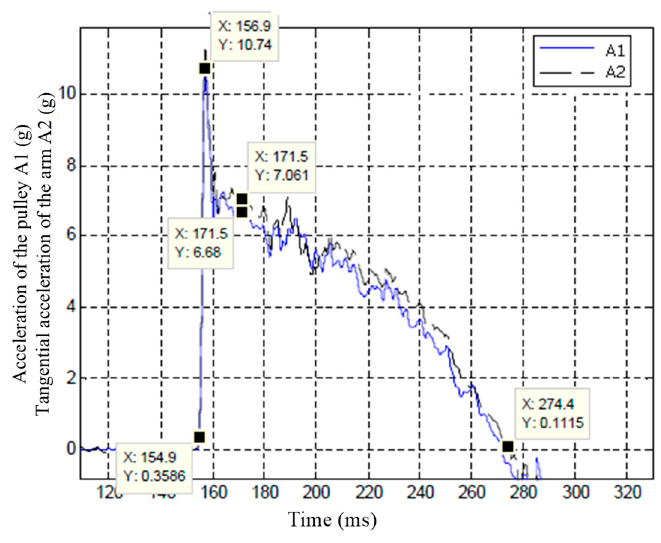
Figure 4. Measured acceleration of the pulley and the tangential acceleration of the arm at the impact overload of 10 g .